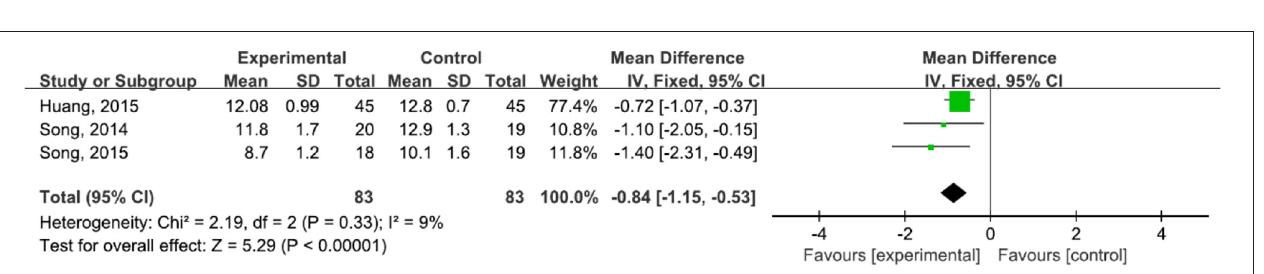
FIGURE 9 | Forest plot showing MD (with 95% CI) for TUGT of the included studies comparing the experimental and control groups.